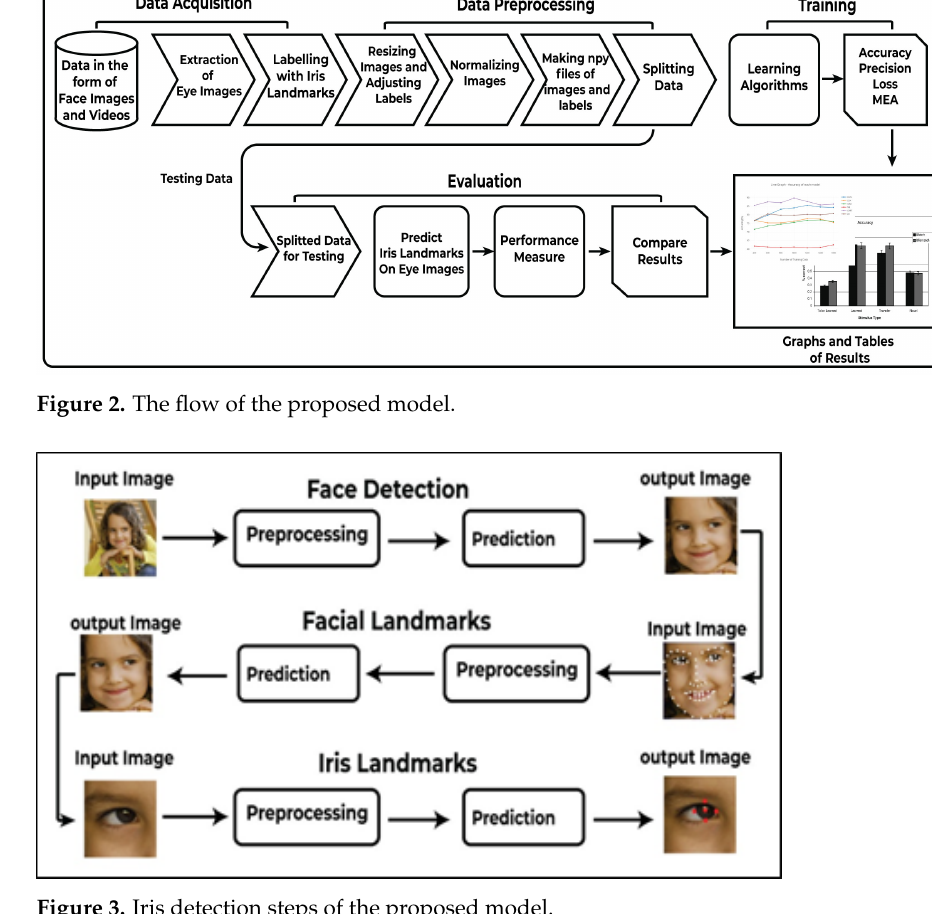
Figure 3. Iris detection steps of the proposed